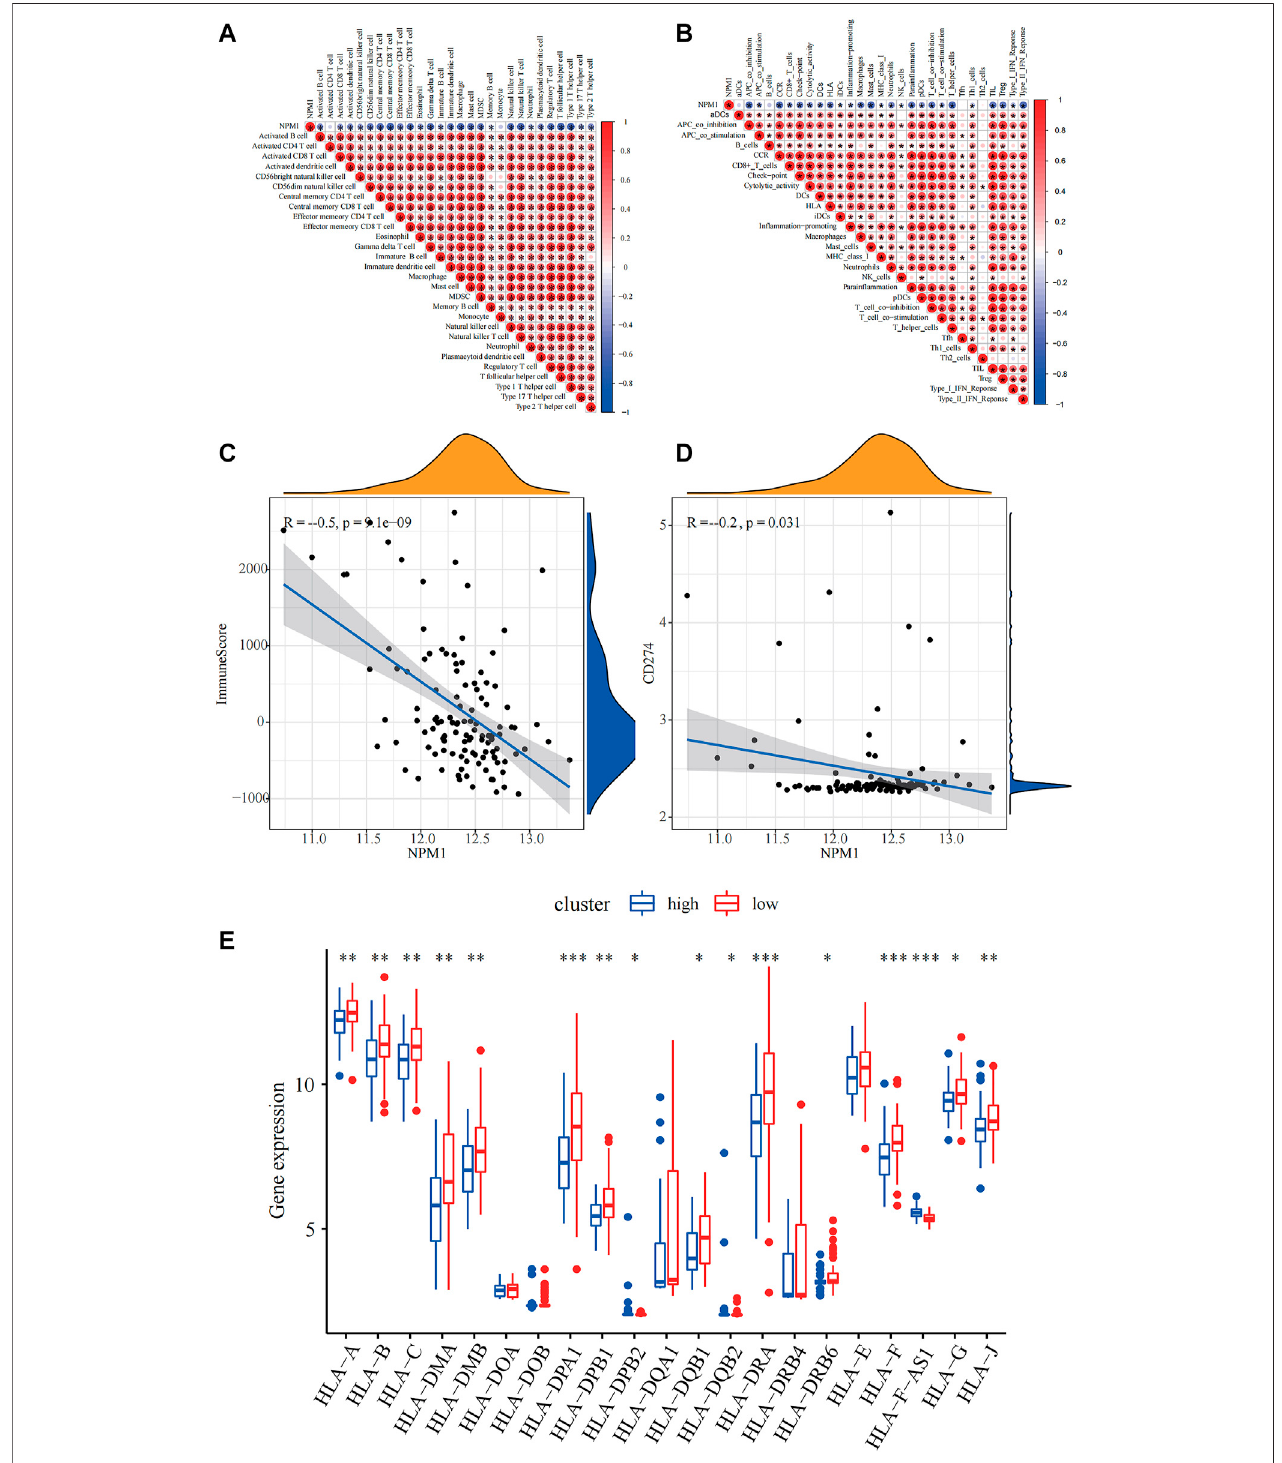
FIGURE 6 | Relevance of NPM1 to immunity. (A) Correlation of NPM1 with single-sample Gene Set Enrichment Analysis (ssGSEA) scoring of 28 immune cells. (B) CorrelationofNPM1with29immunefunctions,immune-relatedpathwaysandssGSEAscoring. (C) CalculationofcorrelationbetweenNPM1andimmunizationscoring based on Pearson correlation coef fi cient. (D) Calculation of correlation between NPM1 and PD-L1 (CD274) based on Pearson correlation coef fi cient. (E) Differences in human leukocyte antigen (HLA) family expression between high and low NPM1 subgroups are demonstrated by box plots.